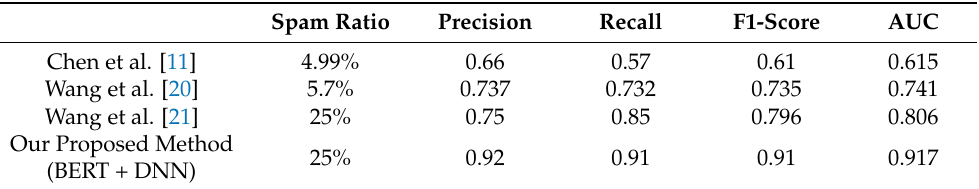
Table 8. Comparison of the classification efficiency between the present and past studies using the Samsung